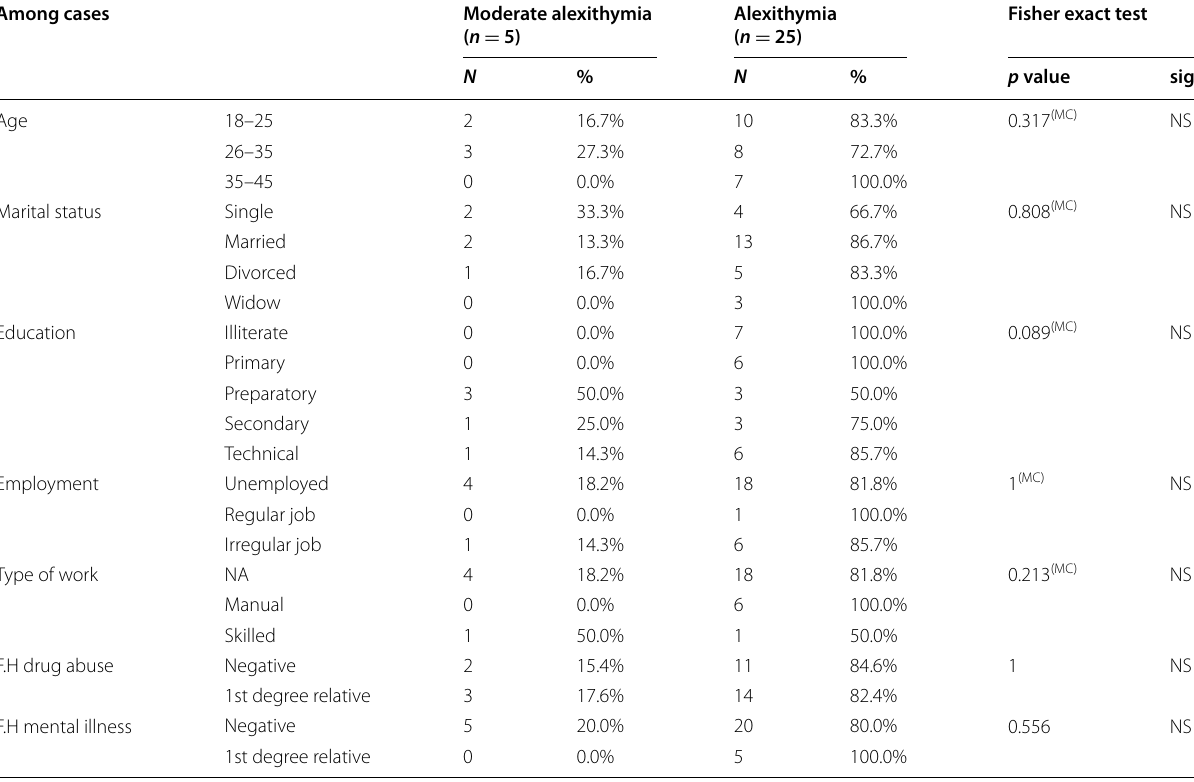
MC Monte Carlo method, NS non-significant, S significant